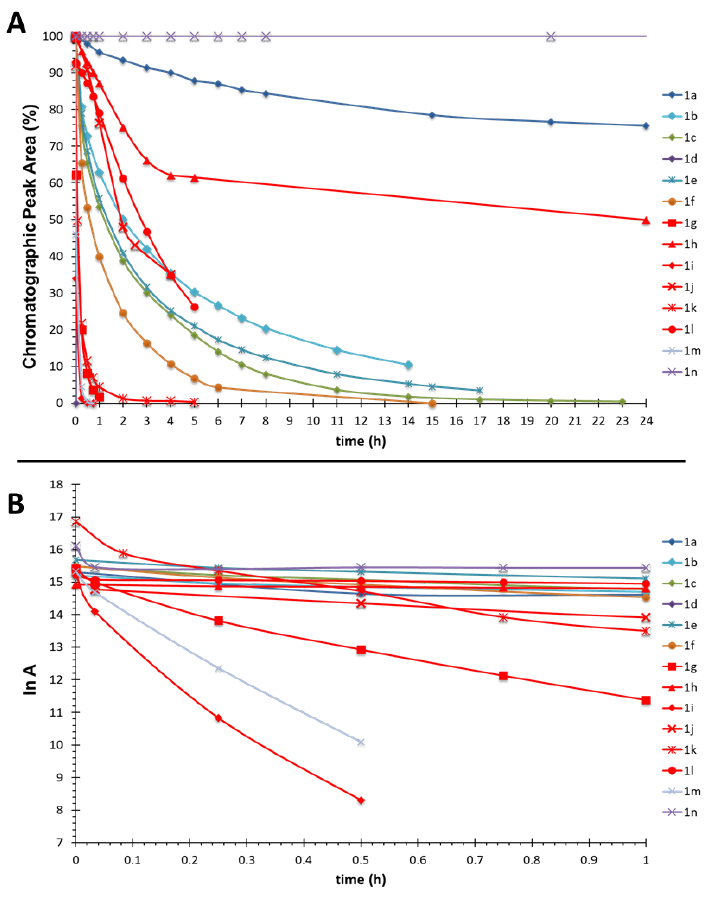
Figure 4. Acidolysis study for compounds 1a-n at 1 mg/mL in TFA/MeCN (1:99). ( A ) Chromato- graphic peak area (%) corresponds to amide degradation at the indicated time and ( B ) linearization of the acidolysis curve, A corresponds to the chromatographic peak area of the amides 1a – n at the indicated time of treatment.